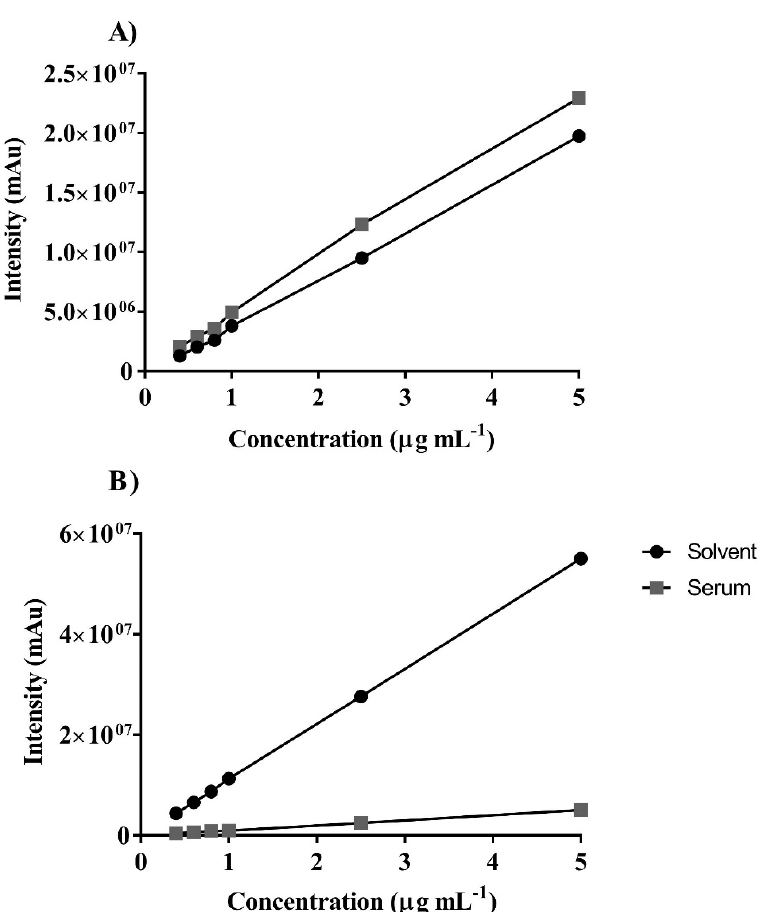
FIGURE 5 – Curves obtained by analyzing samples prepared with solvent and plasma for both drugs; (A) spironolactone’s and (B) canrenone’s concentrations ranged from 0.4 to 5.0 µg mL −1 . Calibration curve equations were (A) y = 2,669,850.49x + 270,168.3 ( r 2 = .9996) for the solvent and y = 4,718,556.1x + 139,019.15, with r 2 = .9998 for the plasma matrix and (B) y = 1711,581.50x + 52,883.47 ( r 2 = .9997) for the solvent and y = 997,542.0x + 2,183.1, with r 2 = .9995 for the plasma matrix. Data show the average of 3 replicates ± SD